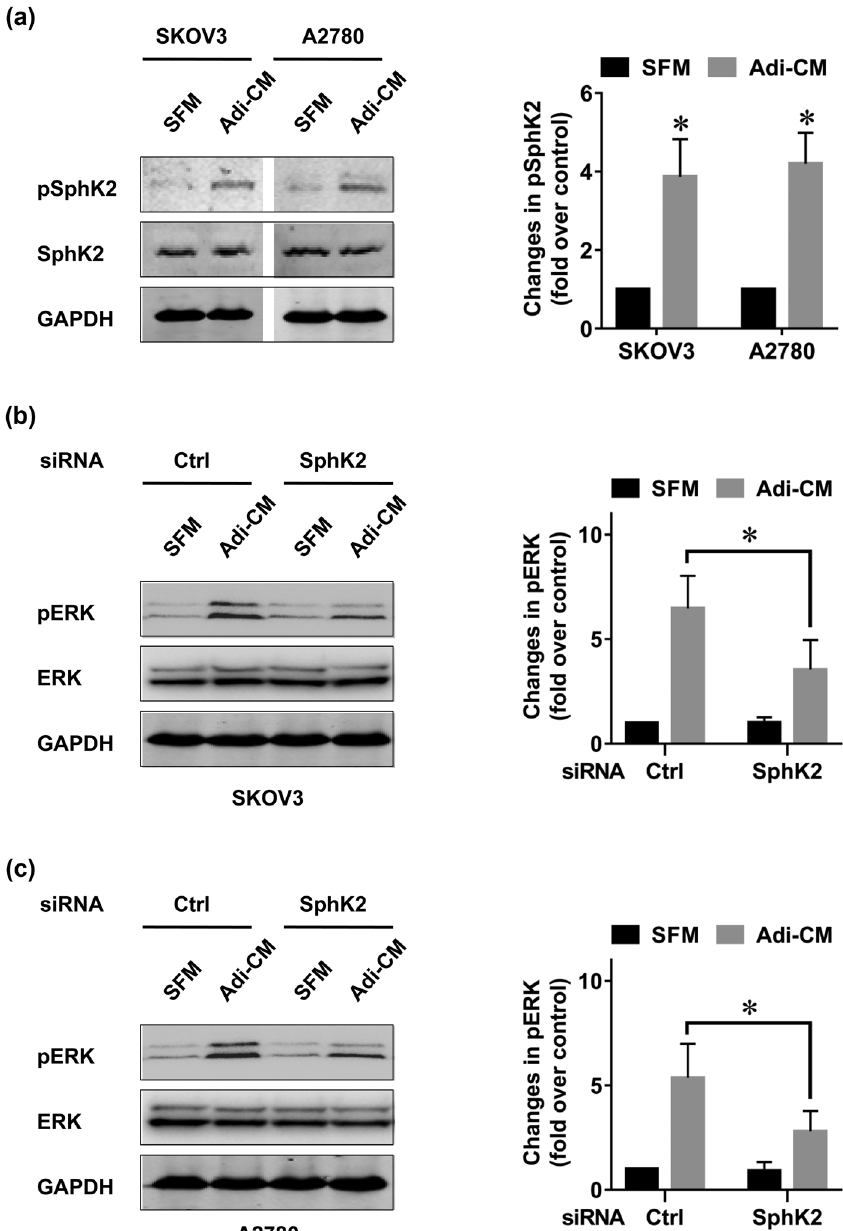
Figure 2: Adipocytes activate the SphK2/ERK pathway in EOC cells. ( a ) SKOV3 and A2780 cells were cultured with SFM or Adi - CM for 24 h. SphK2 phosphorylation was determined by using Western blot. Densitometric analysis of pSphK2 ( normalized to total SphK2 ) is shown on the right. ( b ) SKOV3 and ( c ) A2780 cells were transfected with the indicated siRNAs and cultured with SFM or Adi - CM for 24 h. Total and phosphorylated ERK ( pERK ) levels were then determined by using Western blot. The right panel shows densitometric analysis of pERK ( normalized to total ERK ) . Molecular weight of pSphK2 is 70 kDa, molecular weight of SphK2 is 69 kDa, molecular weight of GAPDH is 36 kDa, molecular weight of pERK is 42, 44 kDa, and molecular weight of ERK is 42, 44 kDa. Data are the mean ± SD. *, P <